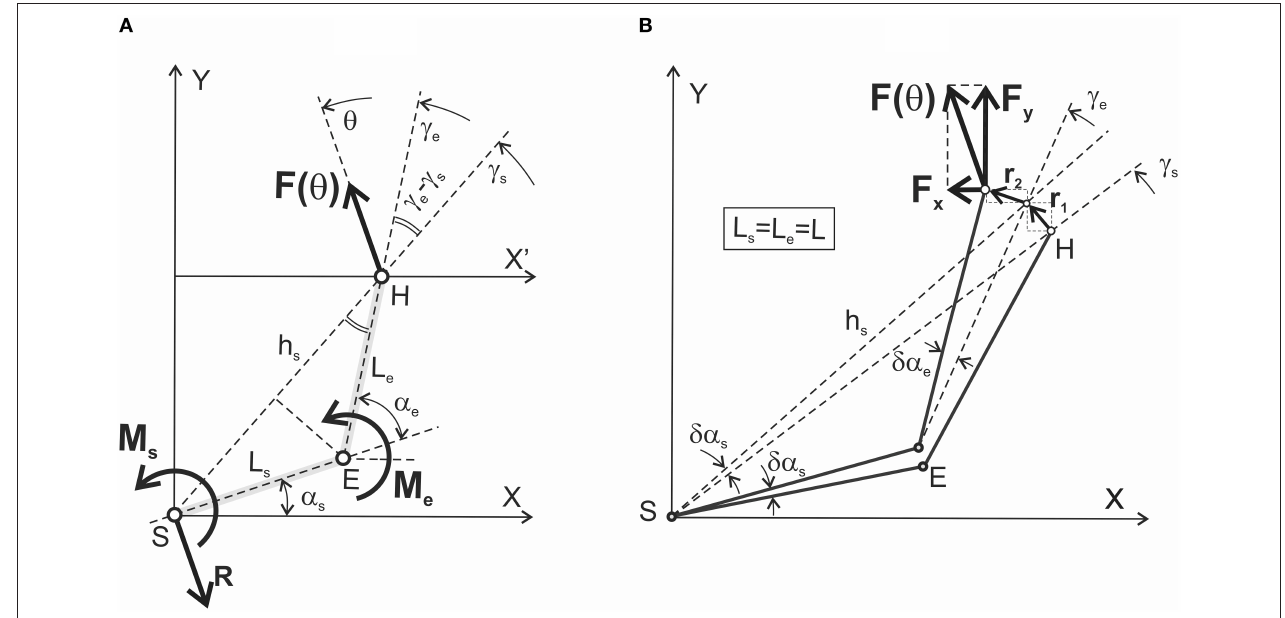
FIGURE 1 | Simplified geometry of the two-joint system with designation of the mechanical parameters defining equilibrium with the surrounding space. (A) A right human arm including the shoulder (S) and elbow (E) joints is chosen as an anatomical analog of the system; a similar two-link configuration is used as a basic element in the models of the robotic arm. A simplified forced interaction of the hand (H) with the environment is considered for the case of rigid wrist immobilization. Main characteristics of the system: L s , L e are the lengths of the proximal (shoulder) and distal (elbow) segments; F ( θ ) is the vector of the isometric force presenting the result of the interaction of the joint torques M s ( θ ) and M e ( θ ), which are directed perpendicularly to the plane upwardly/downwardly for counter clockwise/clockwise turning actions. The problem consists in finding the joint torques M s ( θ ) and M e ( θ ) for all possible directions of the force vector F ( θ ) ( θ ∈ [ 0, 2 π ] rad). Other designations: h s is the distance between the shoulder joint axis (S) and the hand (H), which is considered the end-point; γ s and γ e are the angles between axis X’ and the lines passing via the axes of the joints (S, E) and the end-point (H). The force reaction of the body at the shoulder joint is shown by the vector R = – F ( θ ). (B) Graphical presentation of the method of virtual work used to define the functional interdependence between the generated force and joint torques. A detailed description is presented in the text; note that the simulations in this study have been done under a simplifying assumption that lengths of the proximal and distal segments are equal to each other: L s = L e =